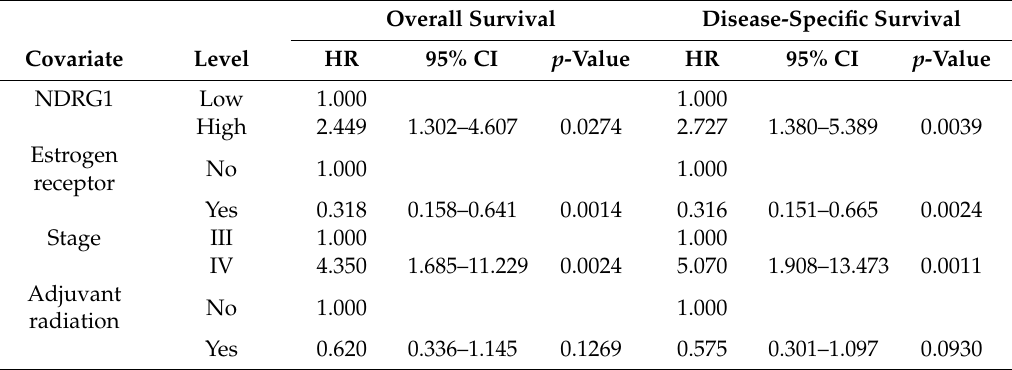
patients with IBC.